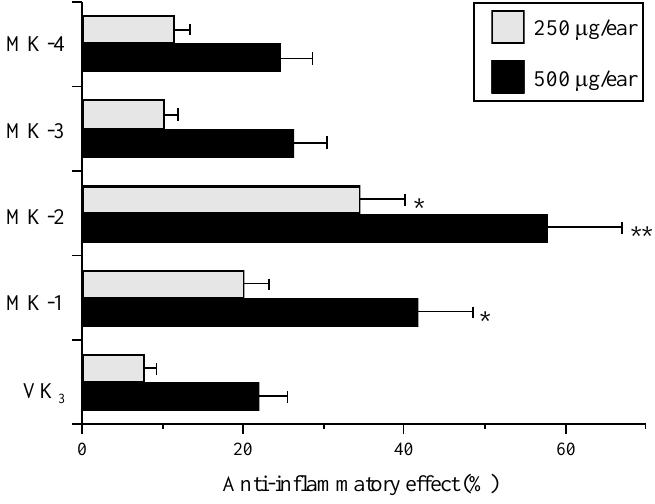
Figure 3. Anti-inflammatory activity of the VK TPA-induced edema on mouse ear. Each compound (250 κg, gray bar; and 500 κg, black bar) was applied individually to one ear of a mouse, and after 30 min TPA (0.5 κg) was applied to both ears. Edema was evaluated after 7 h. The inhibitory effect is expressed as the percentage of edema. Data are shown as the means ± SE ( n = 6). ** P < 0.01 and * P < 0.05 versus